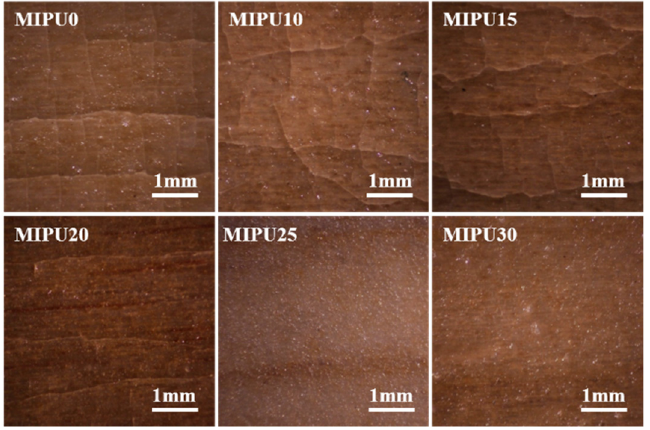
Figure 3. Images of the coatings after cracking tests.